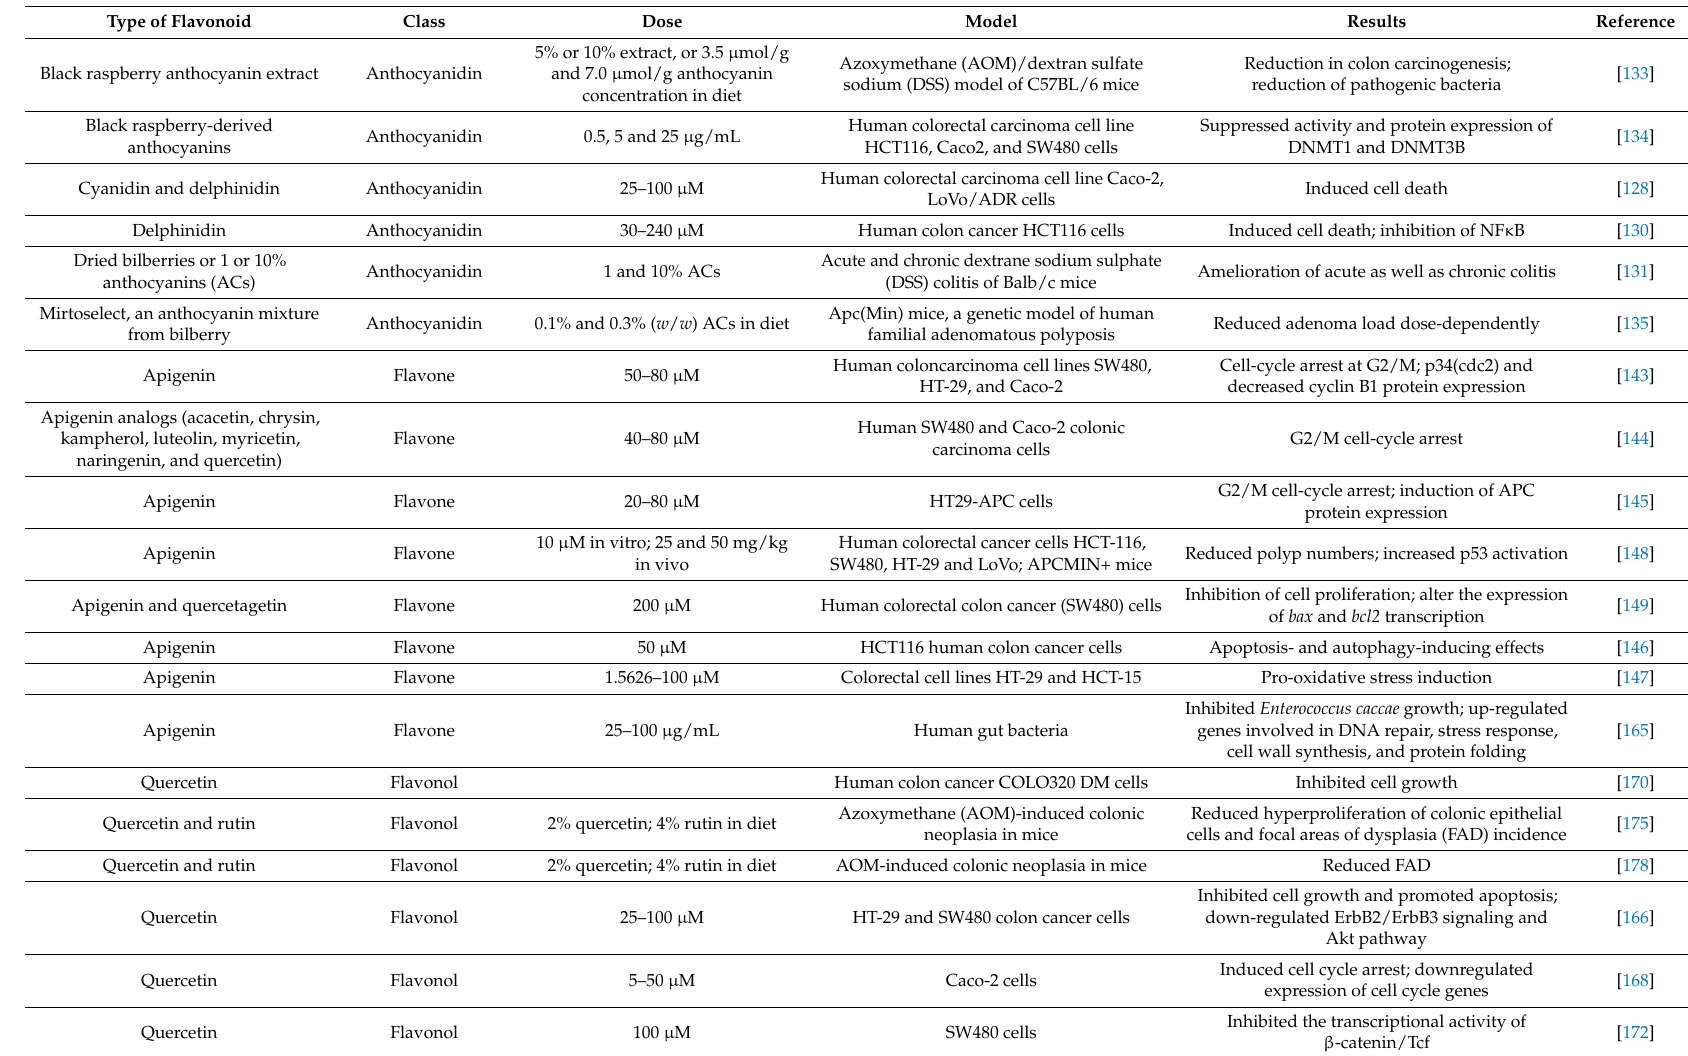
Table 2. Preclinical studies of effect of flavonoids on colon